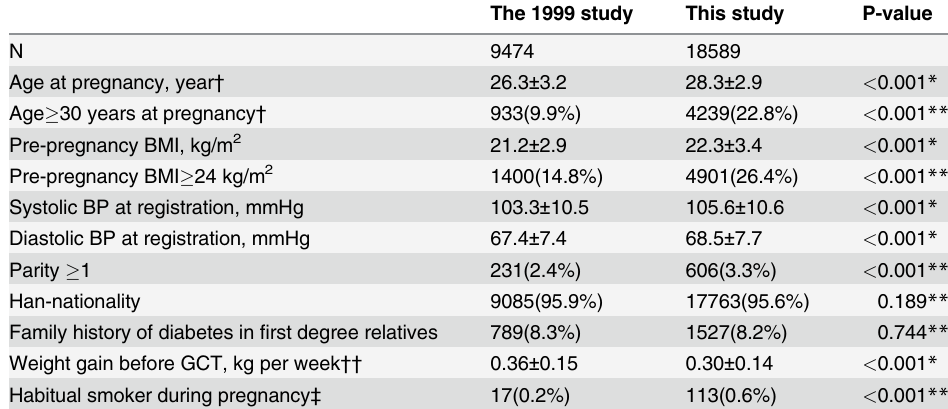
Table 5. Increased prevalence of risk factors among pregnant women in Tianjin from 1999 to 2010 –